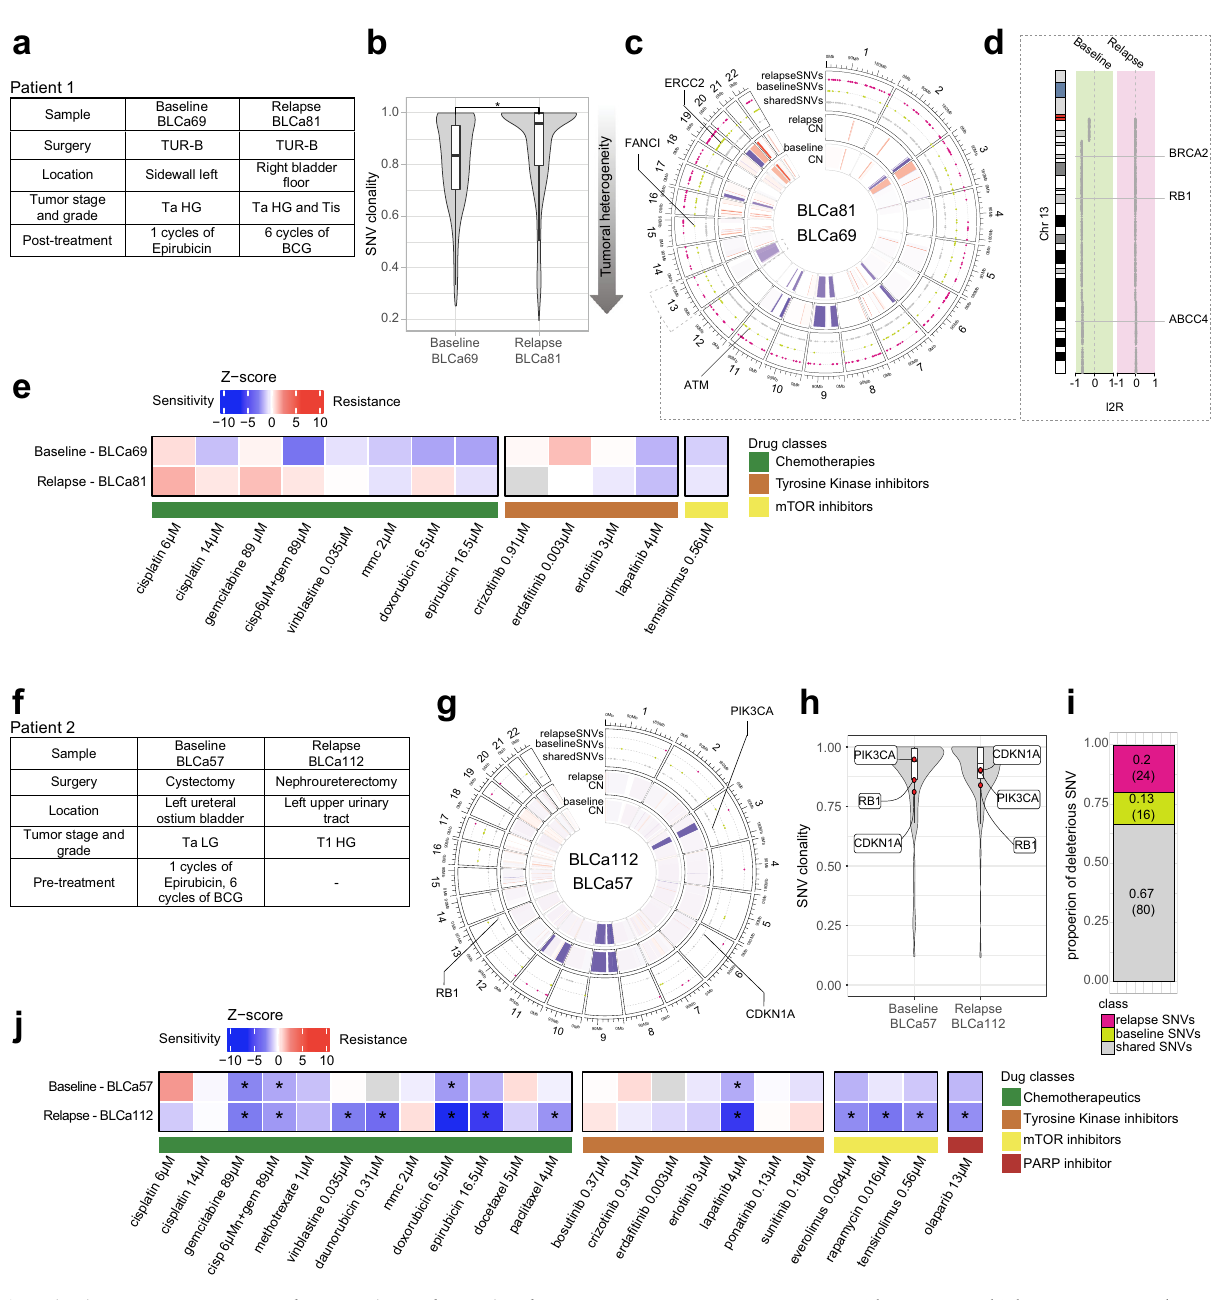
Fig. 6 | Monitoring tumor recurrence and progression and assessing drug sensitivity in vitro with longitudinally patient-derived organoids (PDOs). a Clinical and pathological information of patient 1. b Shared single nucleotide variant(SNV)clonalityinPDOsbaselineandrelapse( n =739baselineSNVs; n =607 relapseSNVs)anditsassociatedgradientoftumoralheterogeneity(arrowpointing to higher tumoral heterogeneity). Box plots indicate median (middle line), 25th, 75th percentile (box), and 5th and 95th percentile (whiskers). Two-sided paired Wilcoxon test, * p -value <2.2e − 16 . c Copy-number (CN) and point mutations pro fi les between PDO from the baseline and the relapse. Relevant genetic alterations are highlighted. e Highlight on chromosome13deletion with affectedgenes. d Results of one PDO drug screen assay on patient 1. Heatmap represents the average of z-scores normalized to the vehicle values from cell viability assays after 48h exposure of PDOs to drugs for one experiment. Samples code is indicated on the right side whereas tested drugs on the bottom of the heatmap. Not available data